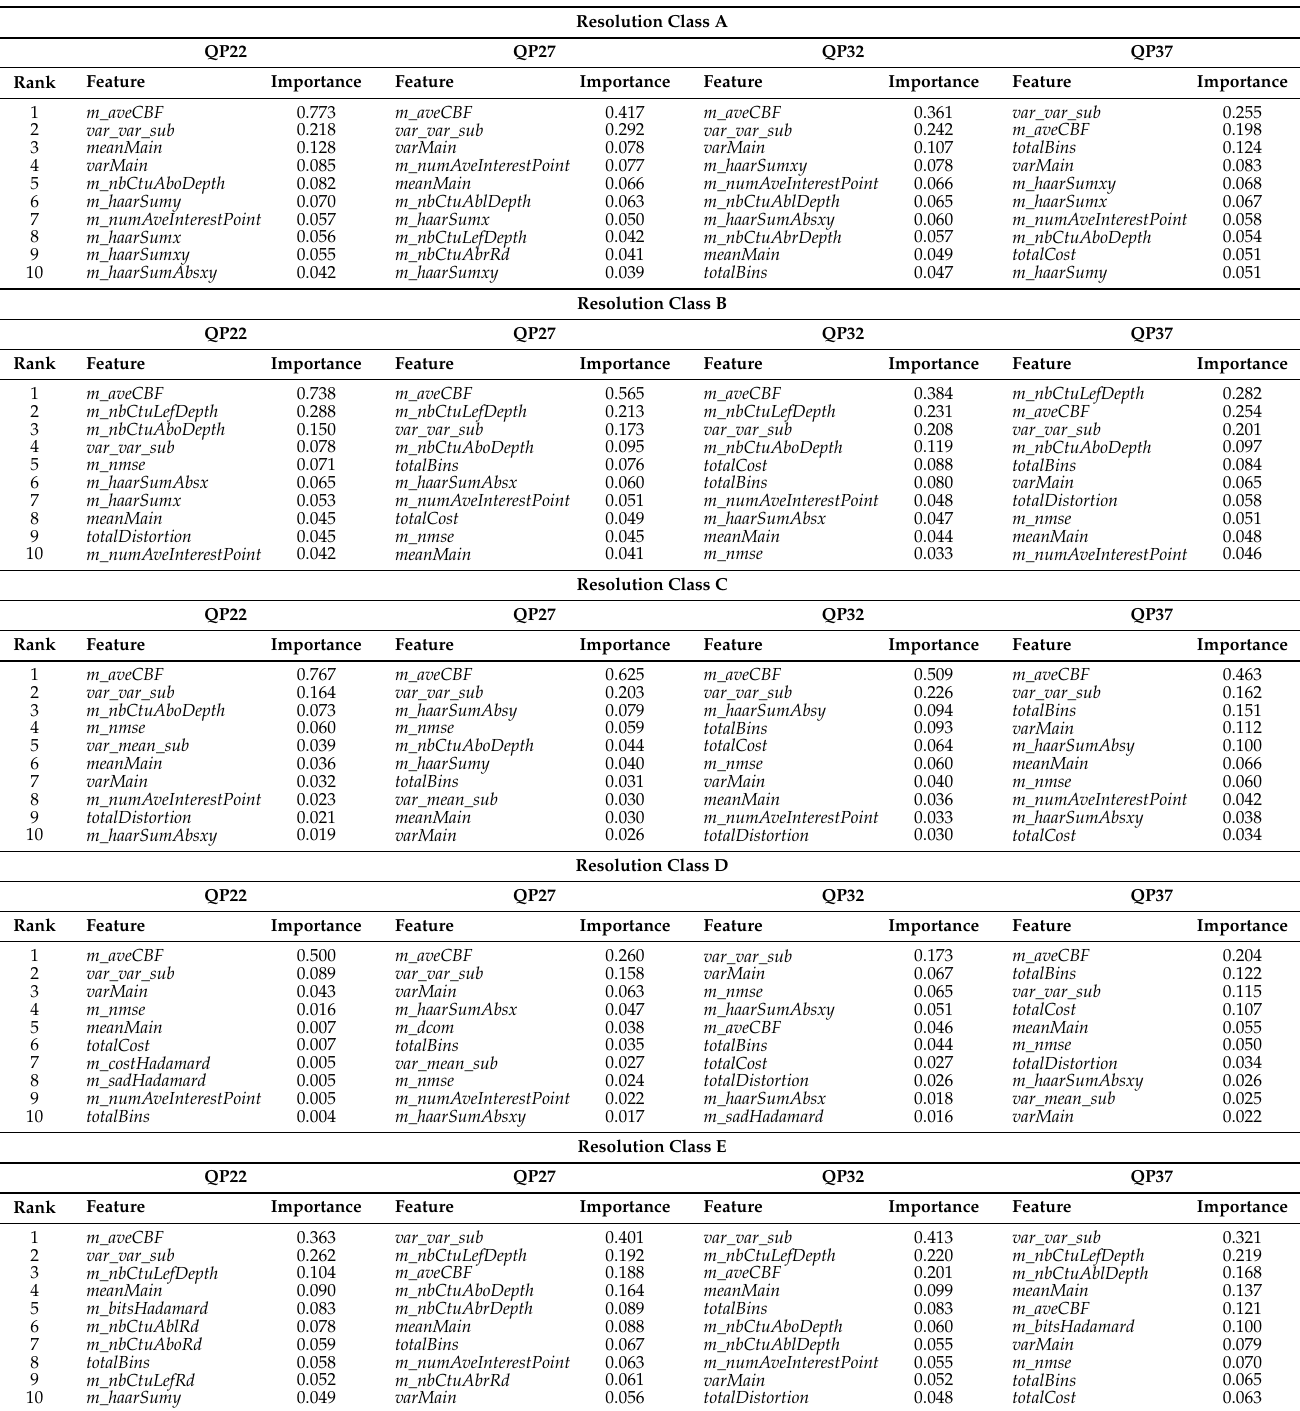
Table 2. Ten most-important features selected for different QPs and resolution classes with corre- sponding importance